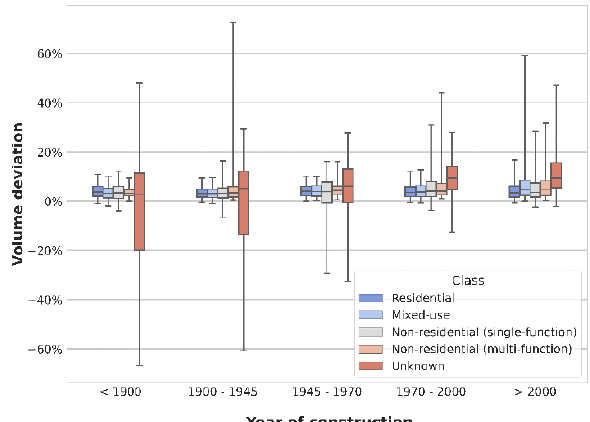
Figure 11 . Distribution of volume differences (in %) between the LoD22 and nDSM models based on age class and building function. Top and bottom whiskers correspond to the 95 th and 5 th percentile, respectively.